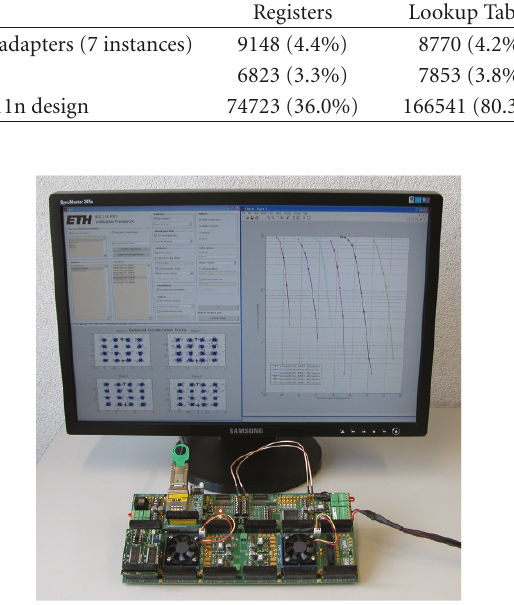
Figure 8: Verification environment software (on the screen: graph- ical user interface (GUI) and result plots) and FPGA emulation